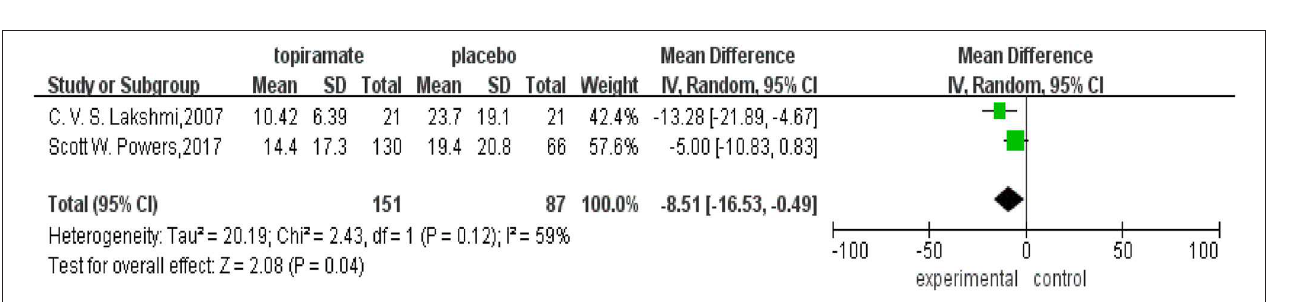
FIGURE 5 | Comparison of Pediatric Migraine Disability Assessment Scale (PedMIDAS) scores between topiramate and placebo